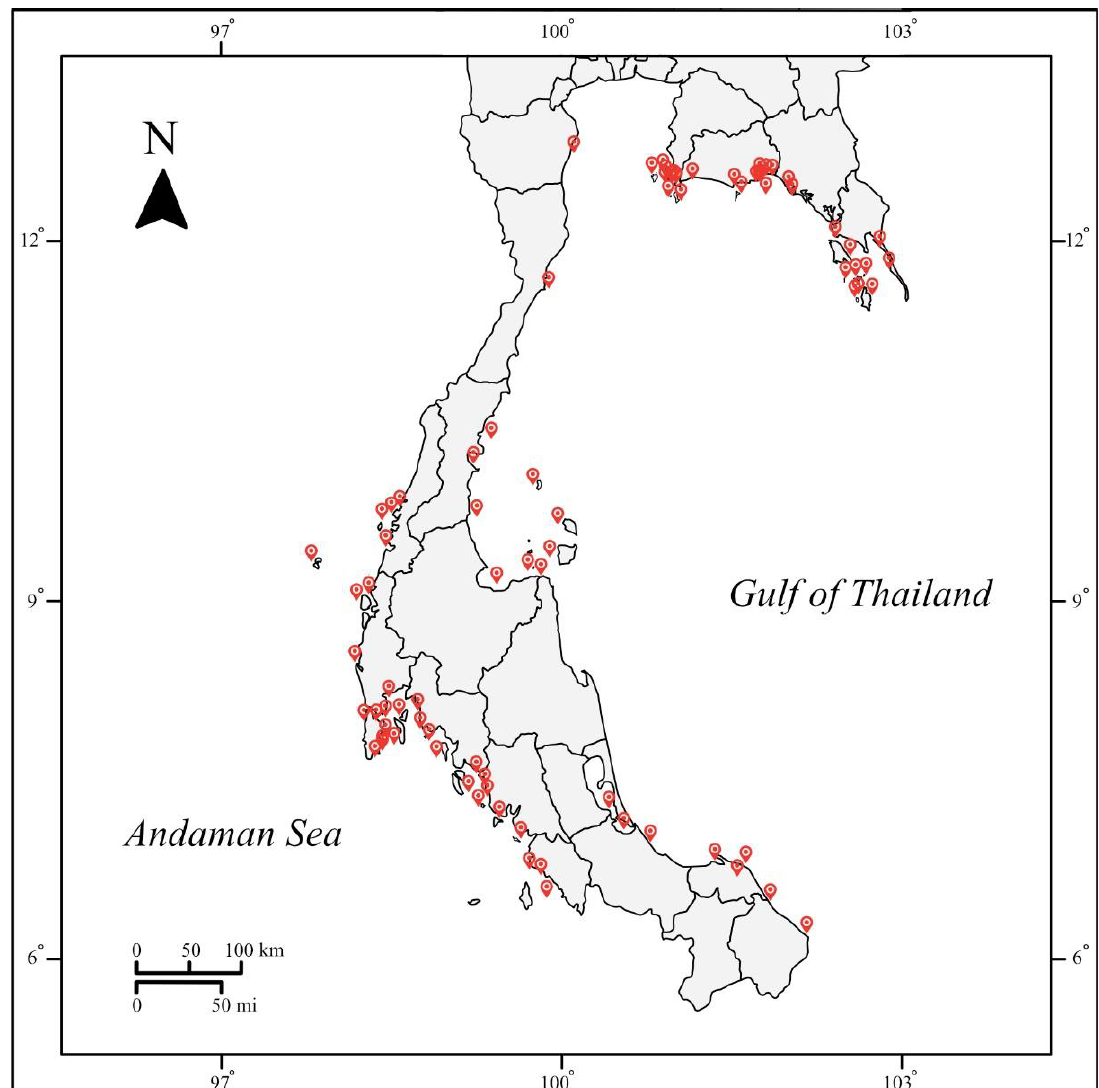
Figure 1. Map of eighty-two studied seagrass areas used for ecosystem services (ES) and vulnerability (VU) analyses.